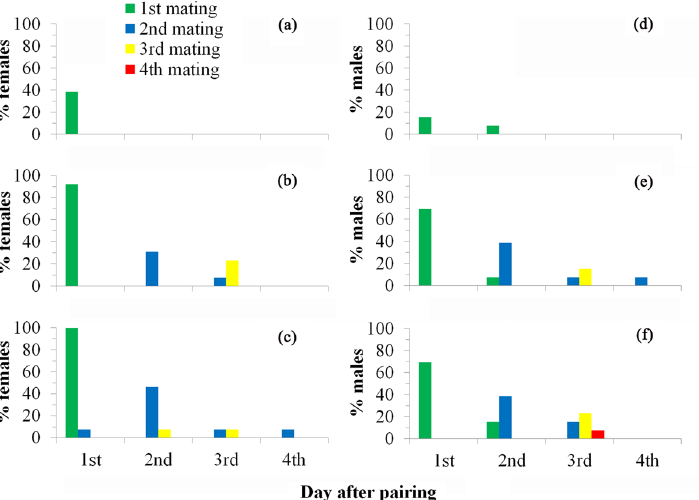
Figure 5. Effects of NTL RNAi on male and female lifetime mating and remating patterns. ( a ) mating pattern of NTL dsRNA females; ( b ) mating pattern of EGFP dsRNA females; ( c ) mating pattern of Water females; ( d ) mating pattern of NTL dsRNA males; ( e ) mating pattern of EGFP dsRNA males; ( f ) mating pattern of Water